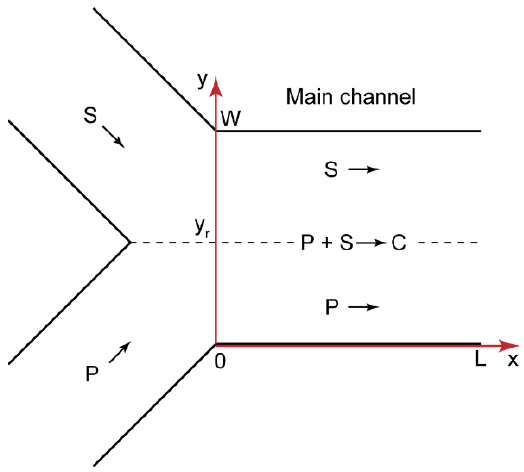
Figure 3. Geometry of a Y ‐ type microfluidic chip with the length L and the width W; P—polyelec ‐ trolyte, S—surfactant, C—complex; y r is the radial coordinate of the reaction front. The interaction of surfactant molecules with monomer binding sites on a macromol